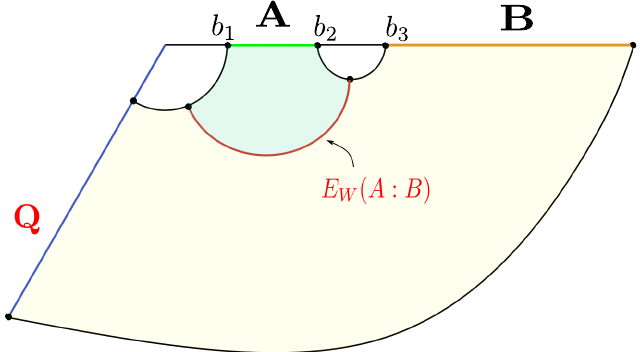
Figure 10. Schematics of the entanglement wedge cross section corresponding to phase-II confor- mally mapped the static mirror setup. Figure modified from